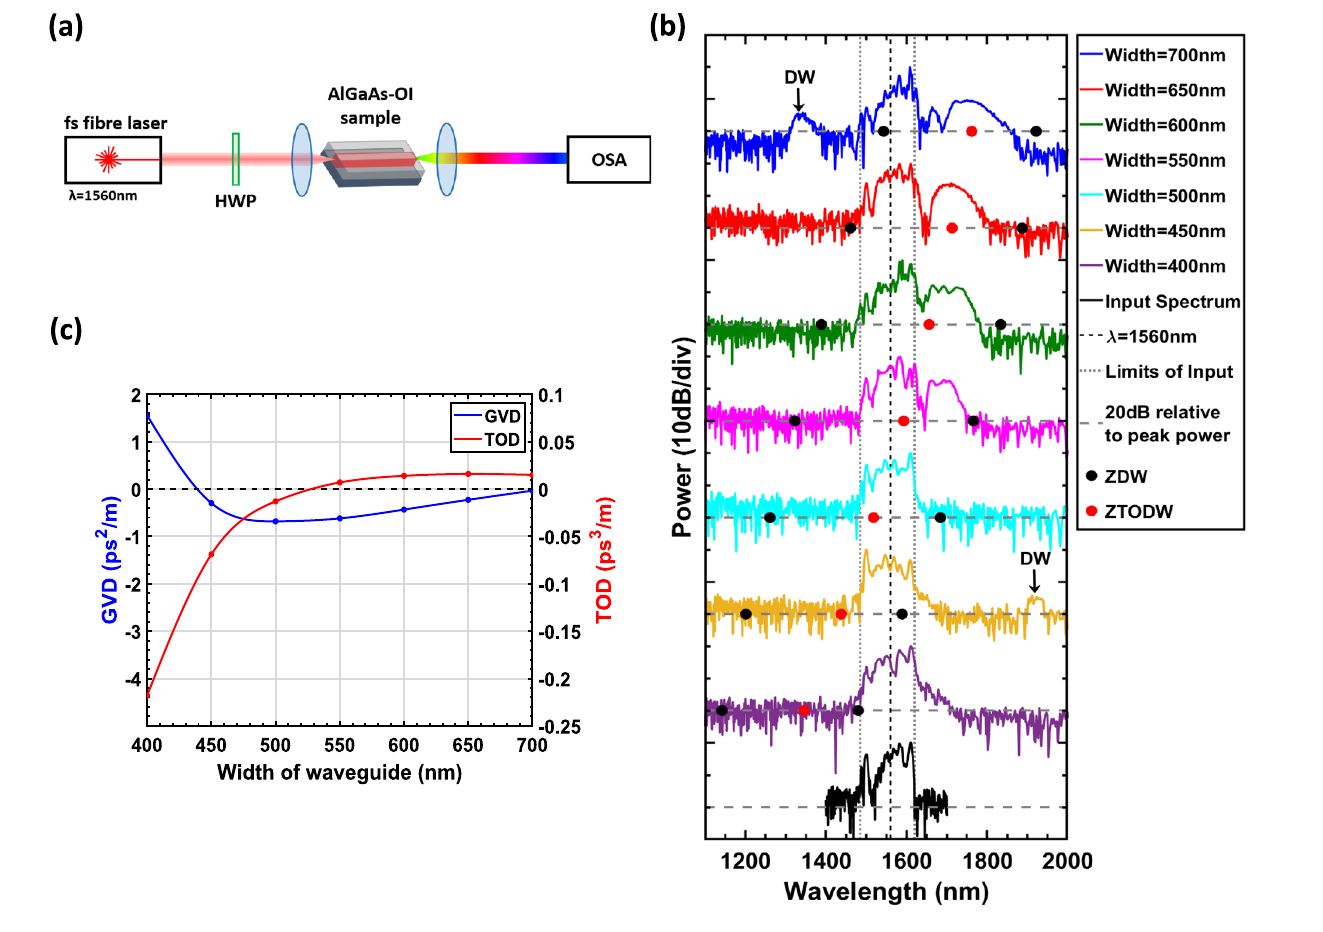
Figure 3. Supercontinuum spectra ( a ) Experimental setup used for SCG ( b ) Experimental results of how the SC spectra vary depending on the waveguide width. For each waveguide width, the pulse energy in the waveguide was ∼ 3.1 pJ. The zero dispersion wavelength (ZDW) and zero third-order dispersion wavelengths (ZTODW) i.e. where the third order dispersion (TOD) equals zero, are also shown for each waveguide and, where applicable, the dispersive wave (DW) is indicated. ( c ) Simulation showing how the group velocity dispersion (GVD) and third order dispersion at the pump wavelength ( (cid:31) = 1560 nm) change with the width of the